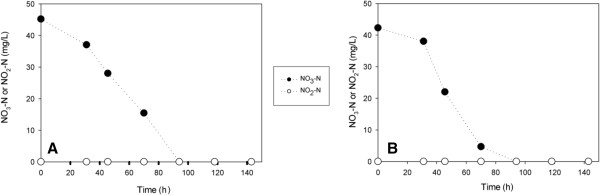
The variations of NO3--N and NO2--N in heterotrophic batch experiments at different initial BrO3- concentrations [45,3 mg/L methanol]. (A) 100 μg/L BrO3-(B) 500 μg/L BrO3-.